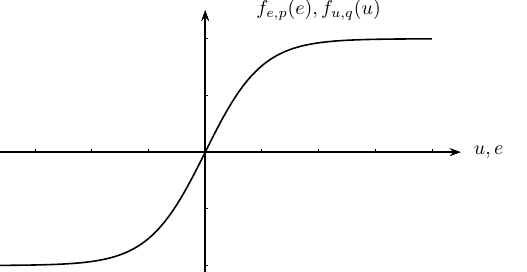
Figure 14. Nonlinear function to implement a discrete time dynamic system.